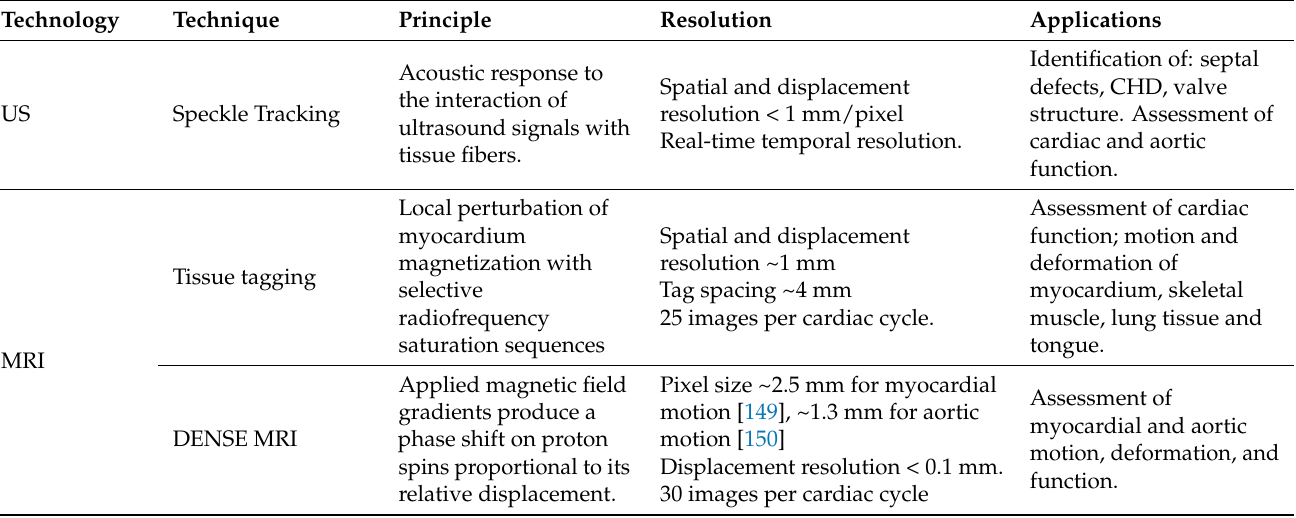
Table 4. Image-based technique for assessment of tissue